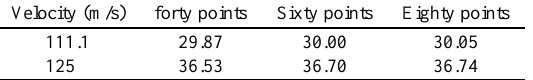
Table 5 The maximal normal displacement at the center on inner surface